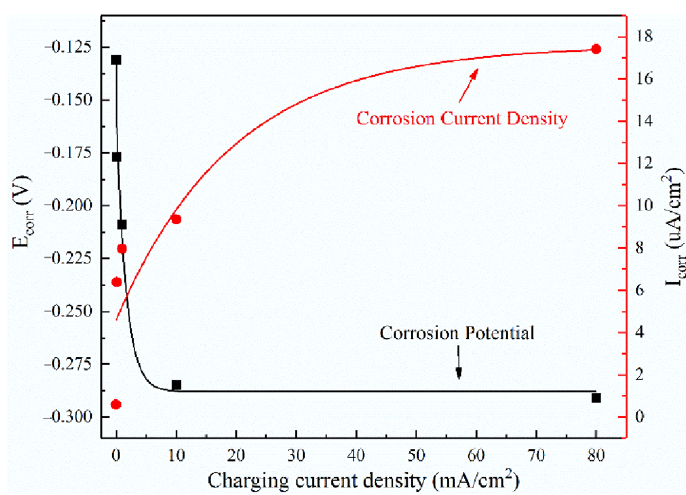
Figure 7. Electrochemical parameters of Tafel polarization curves.